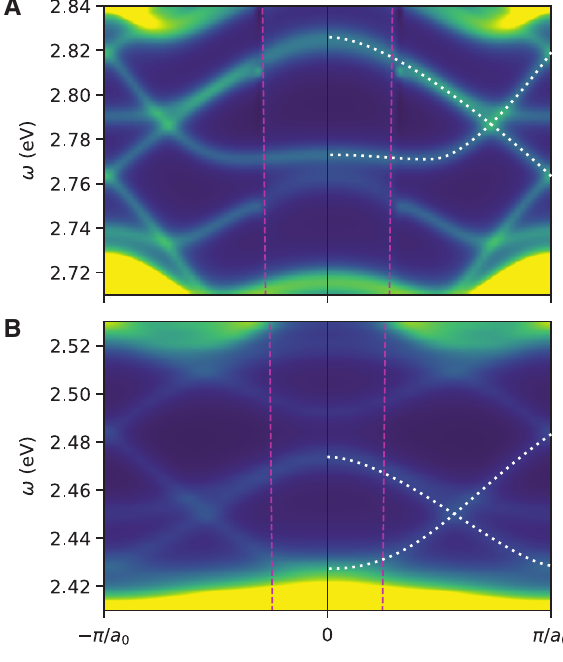
, type II edge. Figure 5: C 3 v The top and bottom media are perturbed by θ = ± 0.1 and rad, respectively. Only modes of one interface are present in the bulk band gap and the dipole moments of these modes are shown either side.